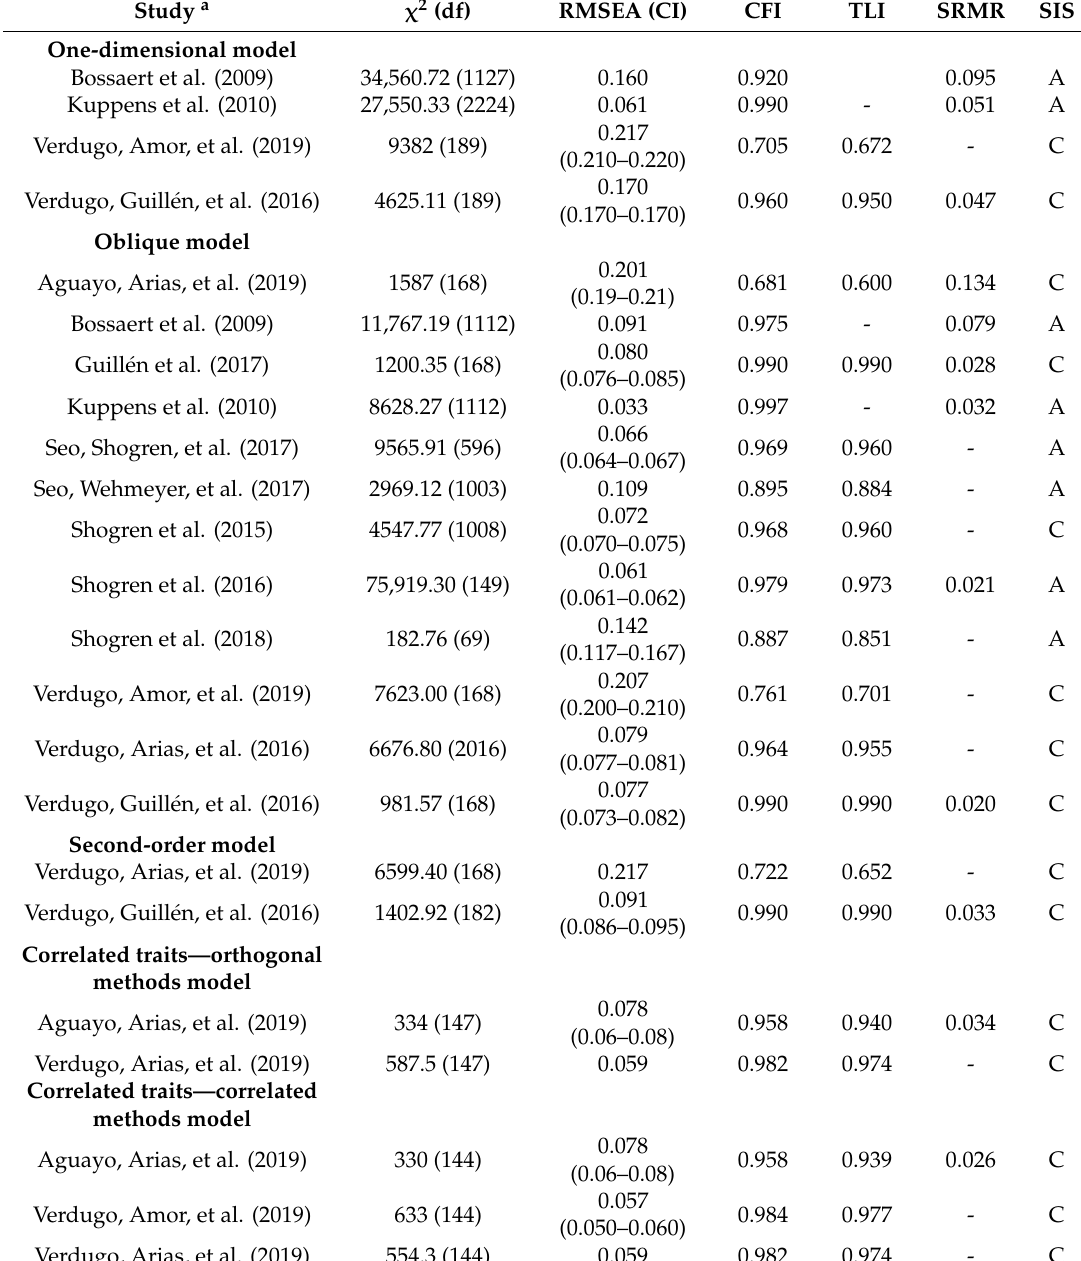
Table A2. Fit Indices of the Support Needs Measurement Factorial